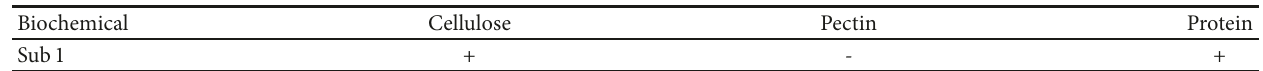
Table 2: Cellulose, Pectin and Protein utilization by the isolated bacteria. Also see supplementary Figure 1 for pictures of plates.